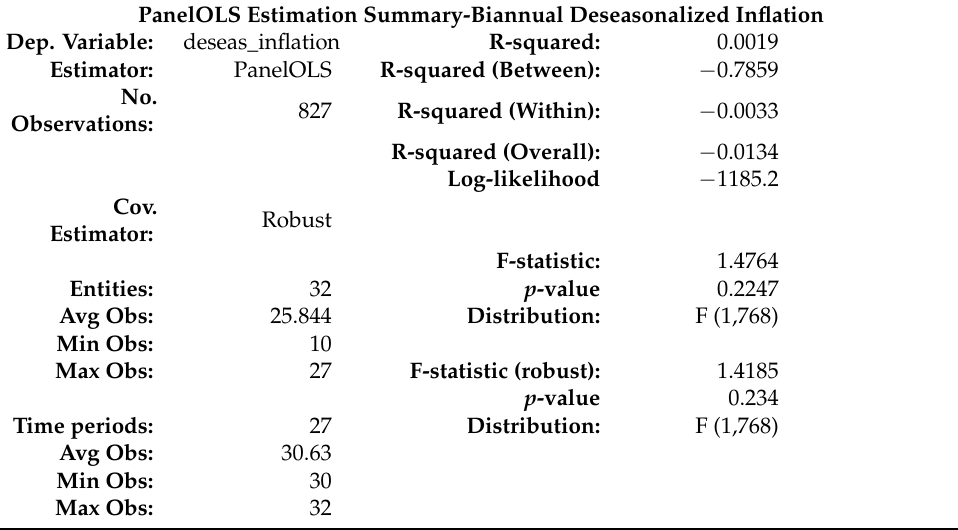
Table 4. The simplest regression of electricity prices on biannual inflation and deseasonalised